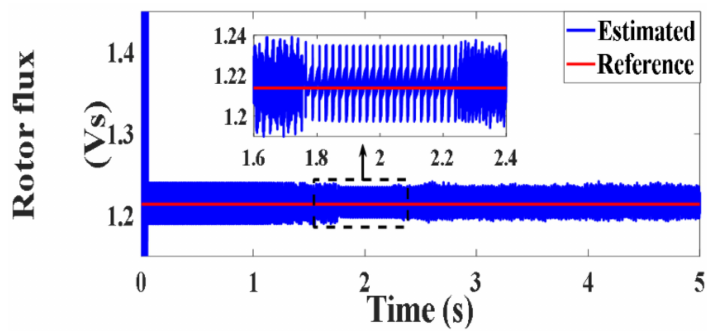
Figure 27. Rotor flux under MPCC (Vs).